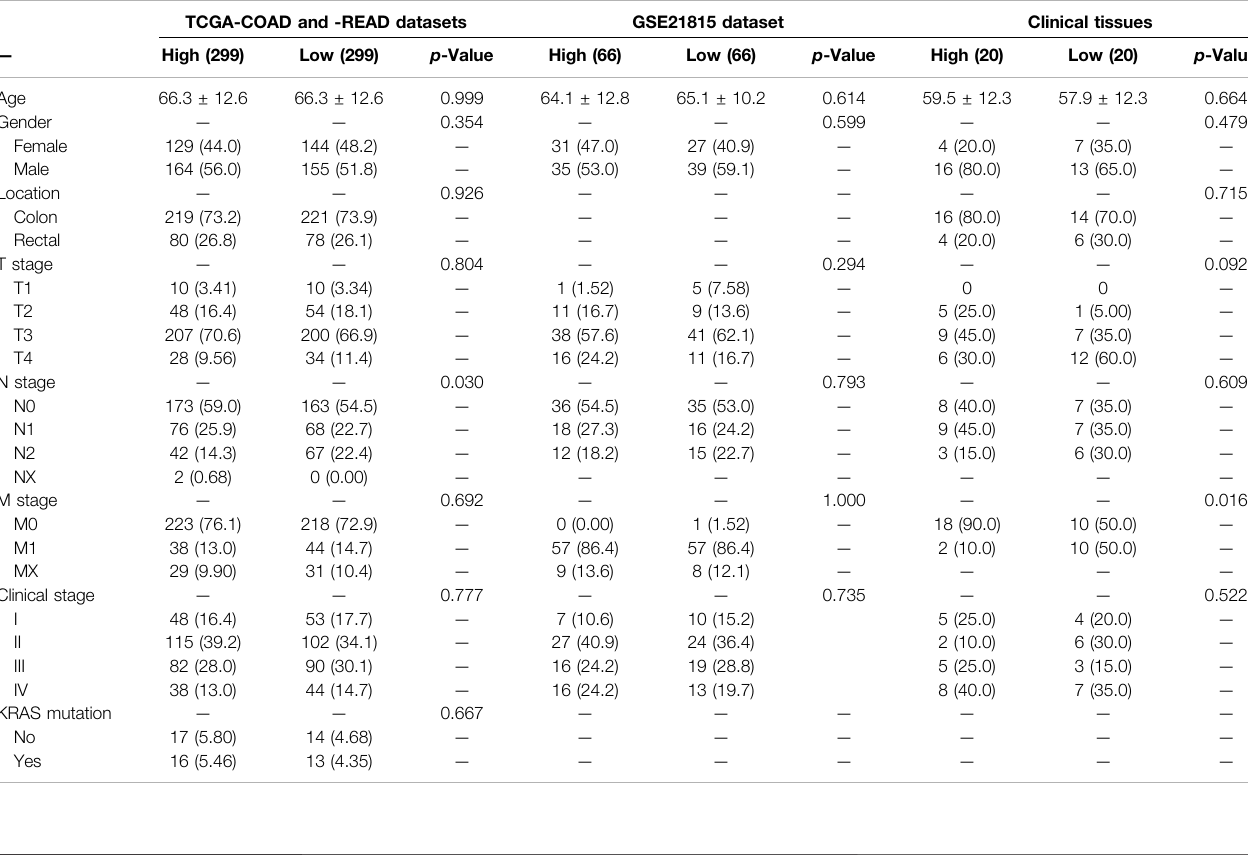
TABLE 1 | Results of clinical signi fi cance of HMMR in CRC using three datasets. TCGA-COAD and -READ datasets GSE21815 dataset